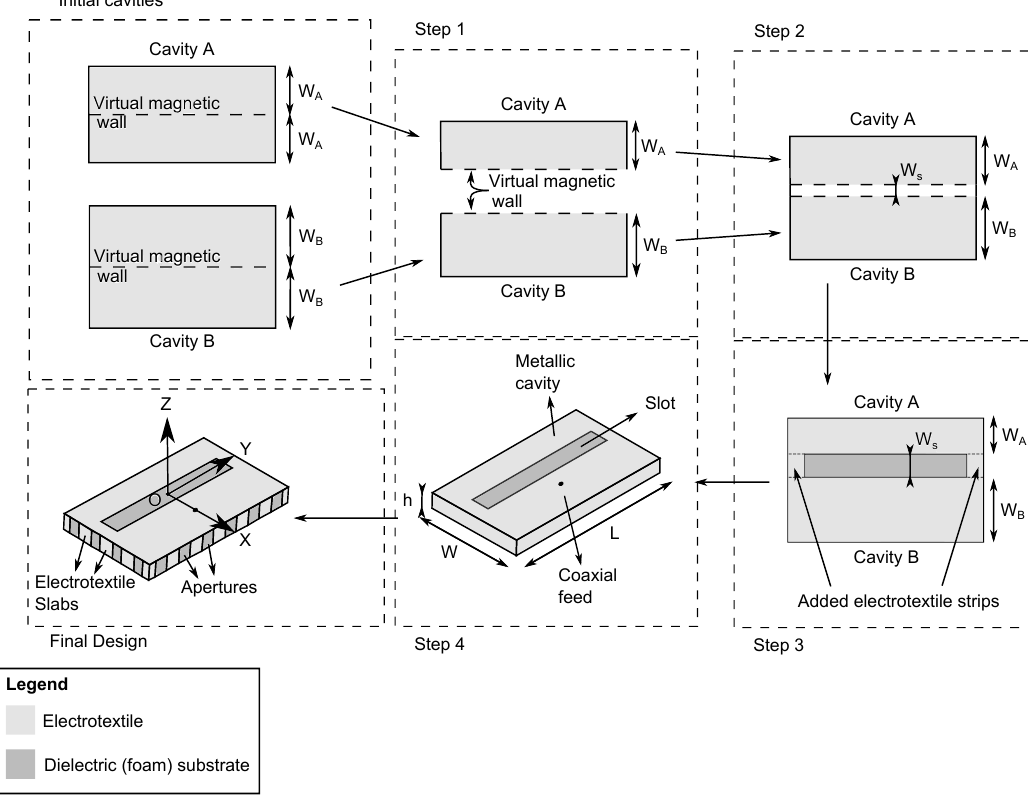
Figure 1. Coupled half-mode cavity design